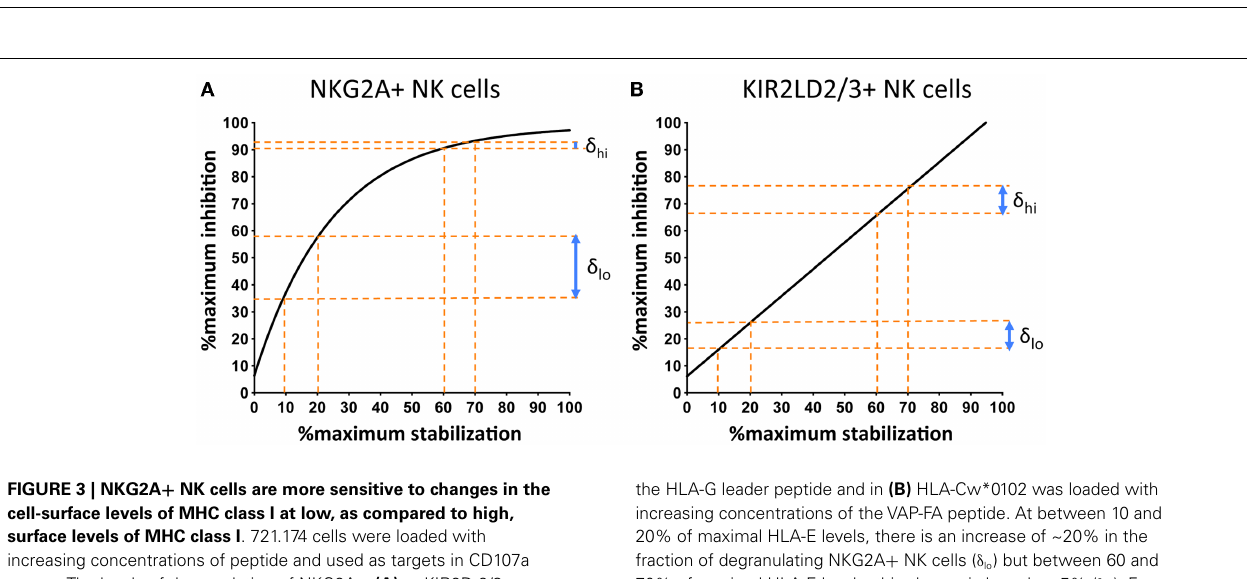
recruited to the immune synapse and there is inhibitory signaling. (C) The synergistic peptide augments the inhibitory signaling due to low levels of inhibitory peptide by stabilizing the immune synapse.